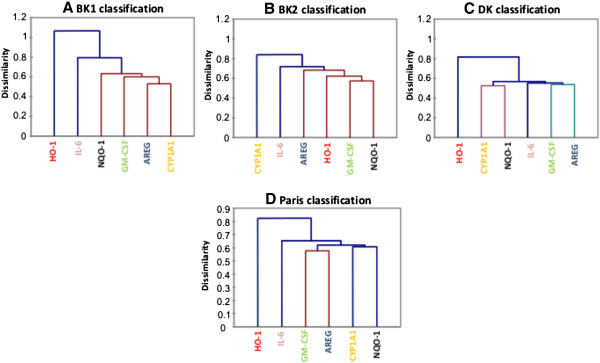
Dendrogram classifications of biological responses for Bamako and Dakar samples in comparison with Paris samples. Classifications were performed with Spearman’s dissimilarity with the mRNA results presented in Figure 4 and Figure 5 for BK1 (A), BK2 (B) and DK (C). Dendrogram classification for Parisian PM was performed with the results of Val et al. [16] (D).